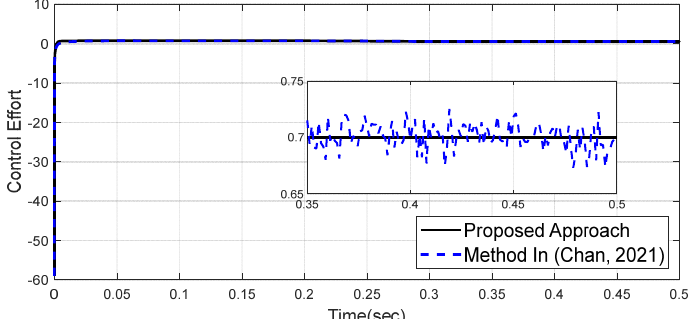
Figure 16. Controller effort signals [1] .